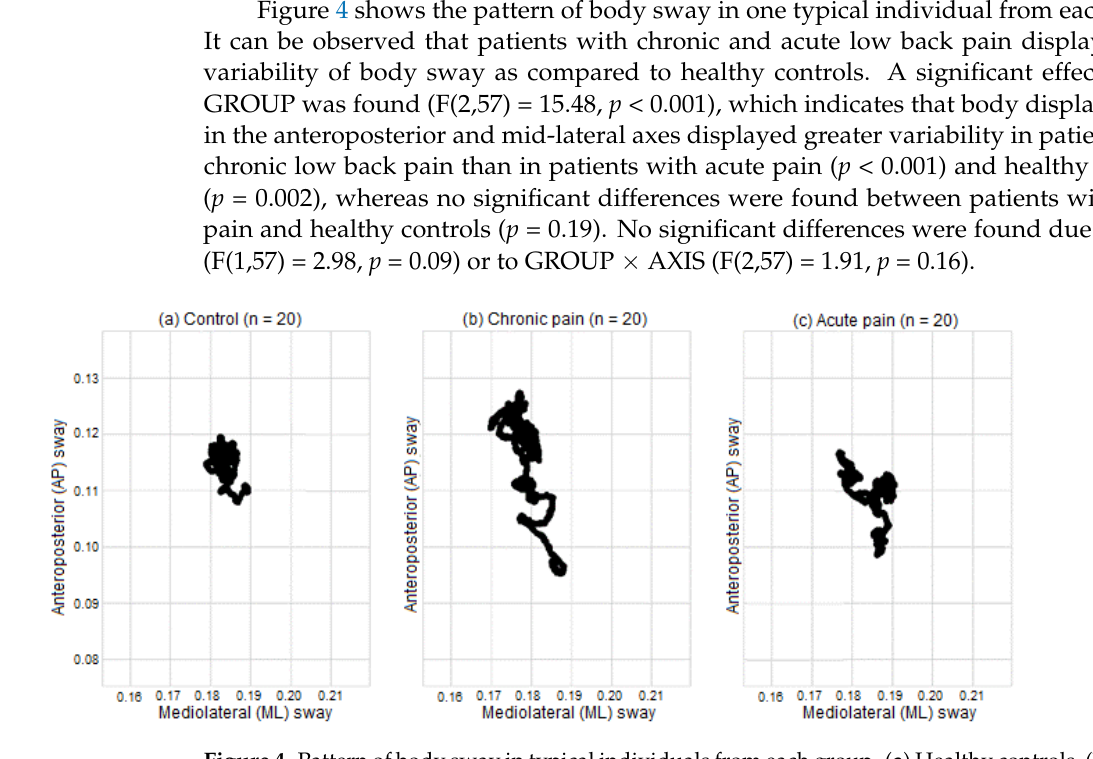
Figure 3. Means and typical errors of depression scores in the three groups (chronic pain vs. acute pain vs. control). ** p < 0.01, *** p < 0.001).